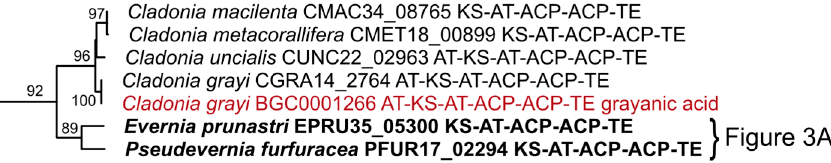
Figure 7. Supported clade containing the gene PKS16 of Cladonia grayi (MIBiG-ID BGC0001266), putatively involved in grayanic acid biosynthesis. The cluster 35 of Evernia prunastri (EPRU35) and cluster 17 of Pseudevernia prunastri (PFUR17) are phylogenetically close and are presented in detail in synteny plot Figure 3A. For the complete KS tree see Figure S1.